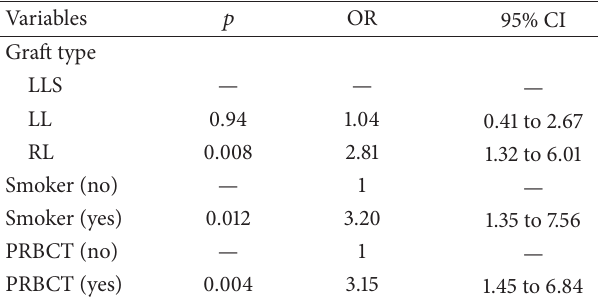
Table 7: Multivariate logistic regression analysis for the develop- ment of complications ≥ grade